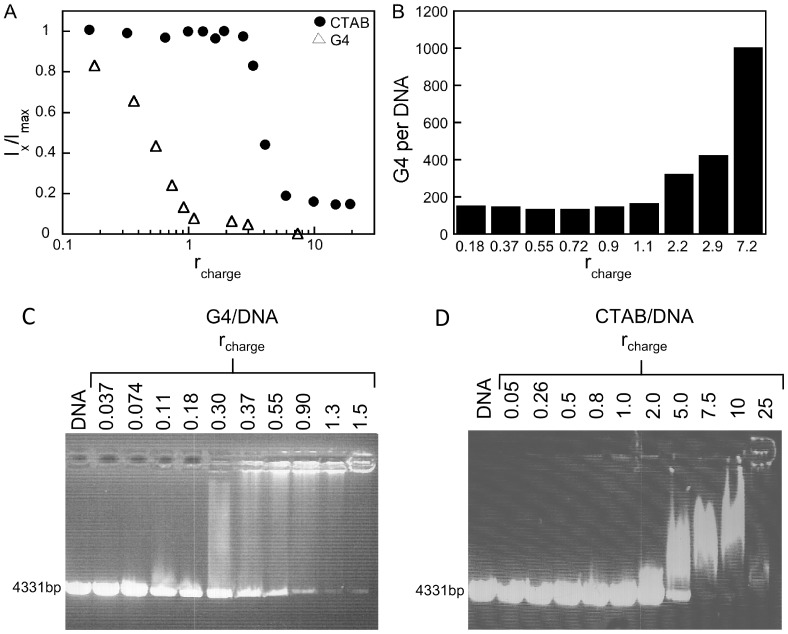
DNA condensation using G4 dendrimers and CTAB surfactants.(A) The fluorescence intensity of GelStar bound to DNA, shown as a function of r
charge in solutions containing 10 mM NaBr for G4 dendrimers (▵) and CTAB (•). Data are normalized to the amounts produced in the samples only containing DNA (in the absence of dendrimer or surfactant) and the I
max value is linearly dependent on the amount of DNA that is available to bind GelStar. The DNA concentration is 2 μg mL−1 and error bars are smaller or equal to the size of the markers. (B) The mean number of G4 per compacted DNA chain at varying r
charge, calculated as described in the text. Note that below charge neutralization the amount of bound G4 per DNA strand is constant, that is each complex contains the same number of G4. Once the neutralization point is reached, the solution only contains compacted DNA and the number of G4 per compacted DNA increases. The results from the electrophoreses study - DNA condensation by G4 dendrimers and CTAB surfactants - are shown in (C) (D), respectively. Lane 1 in both C and D displays free linearized plasmid DNA in the absence of any compacting agent (control, 4331 bp). Samples in lanes 2–11 contain increasing amounts of the compacting agent and the corresponding r
charge values are indicated. The DNA concentration was 25 μg mL−1 and the gels were stained with Ethidium Bromide (EtBr).